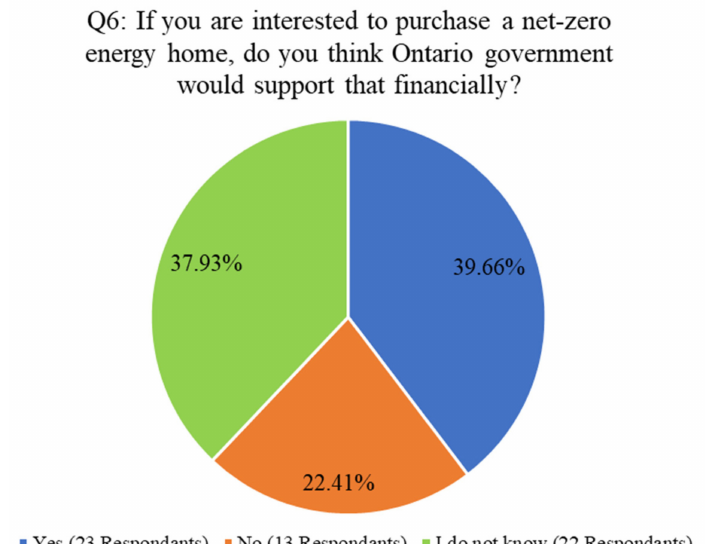
Figure 7. Participants’ thoughts on governmental support towards purchase of NZE homes.